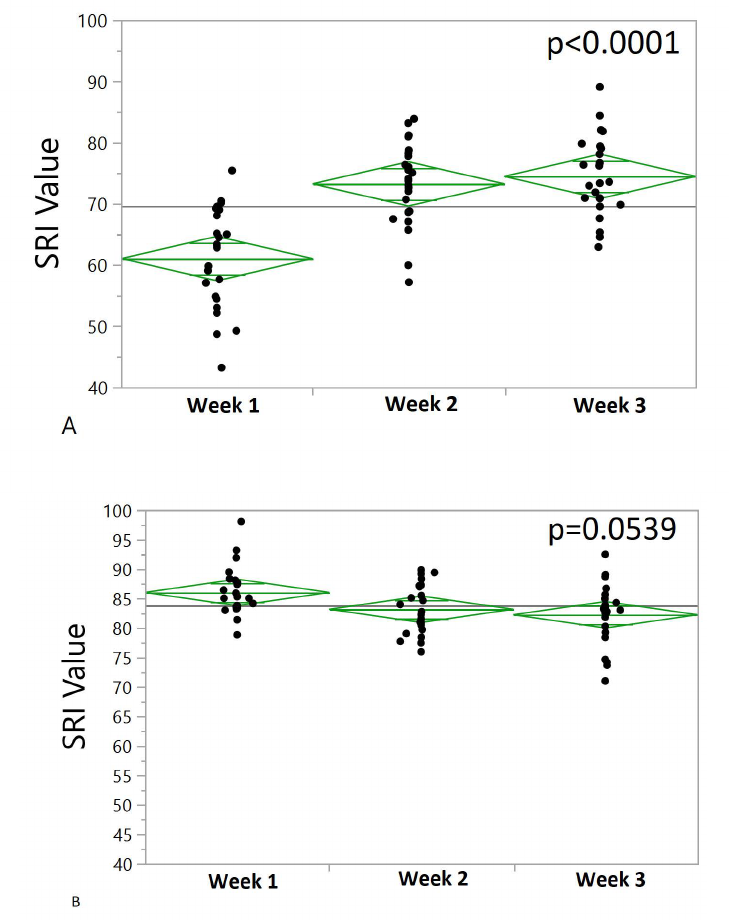
Figure 1. One-way plot of weekly Sleep Regularity Index (SRI) values for bottom and top quartile sleepers. Green diamonds represent confidence intervals. The center line represents the group mean. The vertical span of each diamond represents the 95% confidence interval for the mean of each group. ( A ) Bottom 25% irregular sleepers during week 1 (N = 24). Weekly SRI values (y-axis) segregated into corresponding weeks: week 1, week 2 and week 3 (x-axis). Repeated measures ANOVA shows p < 0.0001, N = 24. As shown by the middle line of each diamond, an average increase of SRI over three weeks is shown. The most irregular sleepers had a significant improvement in sleep regularity during the course of three weeks of inpatient treatment. ( B ) Top 25% of regular sleepers during week 1 (N = 24). Weekly SRI values (y-axis) segregated into corresponding weeks, week1, week 2 and week 3 (x-axis). Repeated measures ANOVA shows p = 0.0539, N = 24. There was a slight average decrease of SRI over three weeks for the top 25% SRI